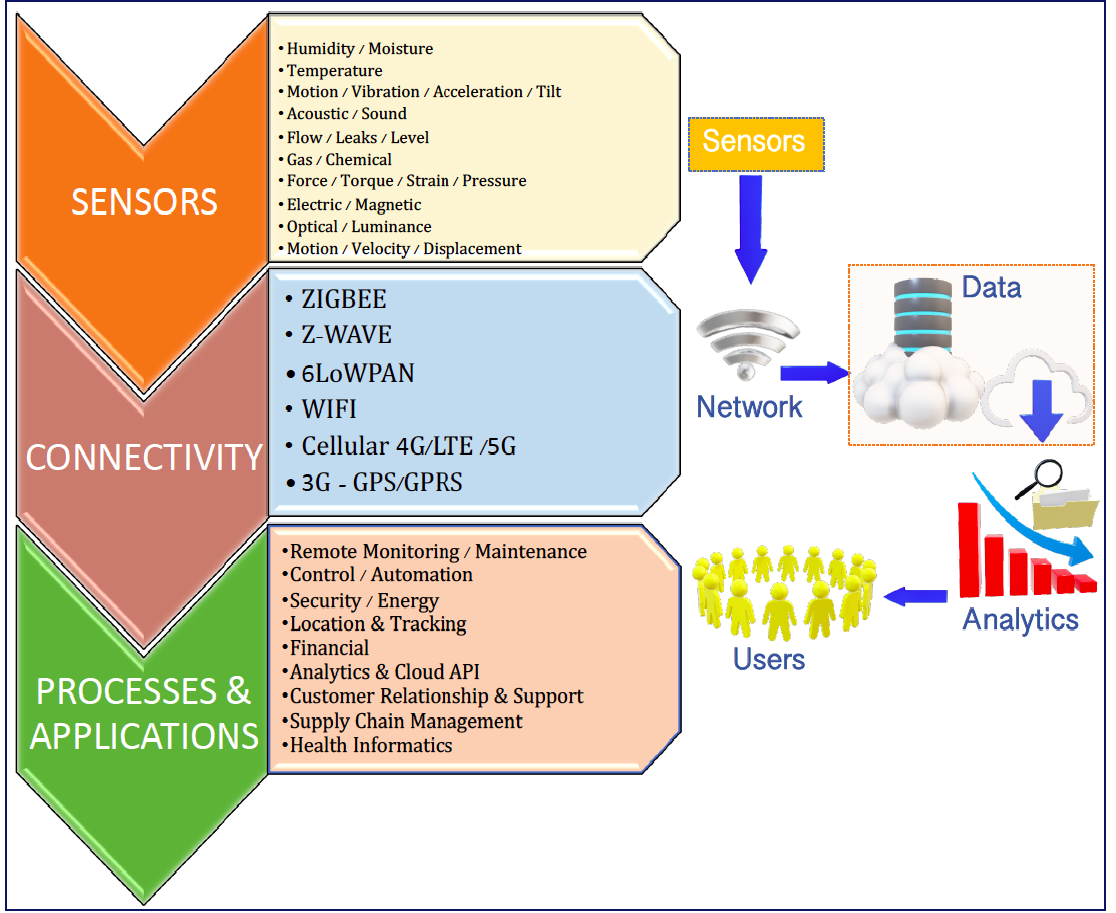
Figure 1. Abstraction of the Internet of Things (IoT)